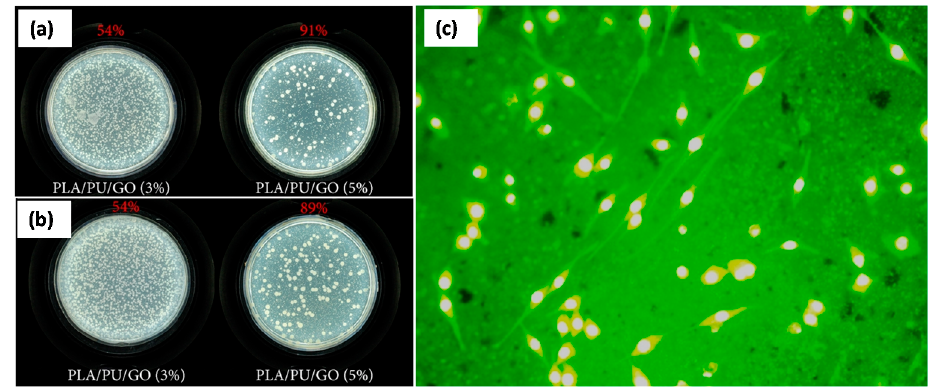
Figure 25. Photographs of ( a ) S. aureus and ( b ) E. coli grown on PLA/PU/GO (3%) and PLA/PU/GO (5%) for 4 h, respectively; ( c ) Fluorescence microscopy image of MC3T3-E1 cells grown on the electrospun PLA/PU/GO (5%) nanofibers for 48 h at 37 °C. The magnification is 100× [84].